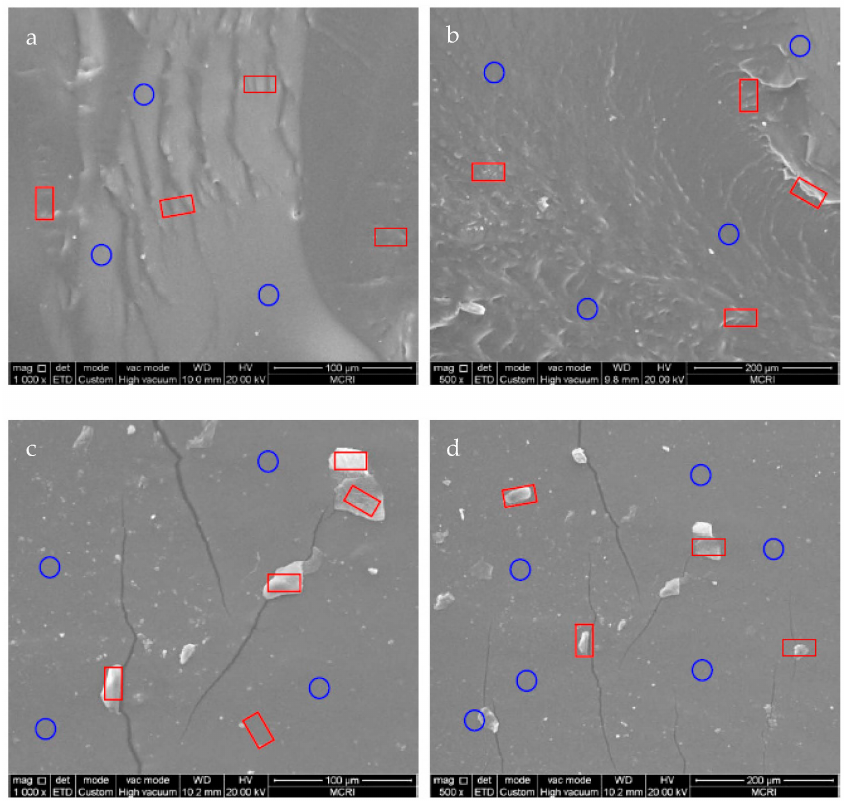
Figure 6. SEM images of freeze-fractured ( a , b ) and tension-fracture ( c , d ) surface of the PET-DA-PU gels. (wrinkles were marked as red square frame, and ravines were marked as blue circle frame).